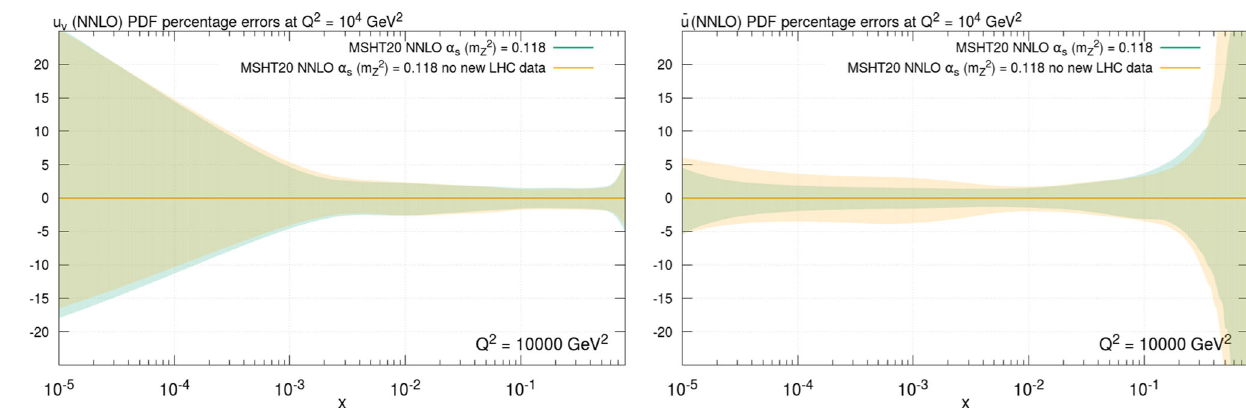
Fig. 53 (Left) Up valence and (right) up antiquark PDF percentage errors upon removal of the new LHC data compared to MSHT20 at Q 2 = 10 4 GeV 2 at NNLO